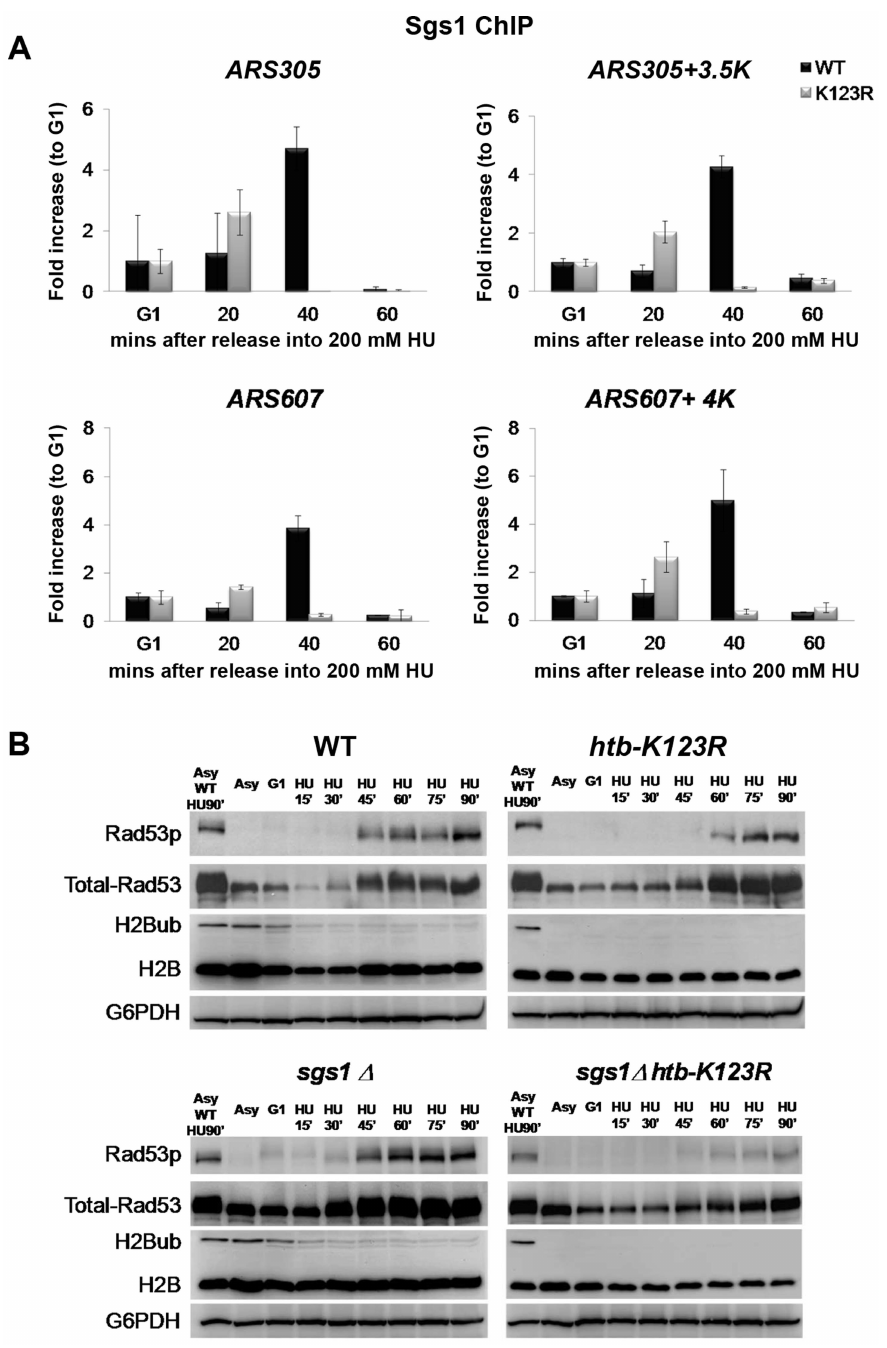
Figure 5. H2Bub and Sgs1 play interdependent roles in Rad53 phosphorylation. (A) Sgs1 occupancy at replication origins is unstable in htb-K123R cells exposed to HU. WT (CFK1764) or htb-K123R (CFK1765) cells were synchronized in G1 and then released into fresh YPD containing 0.2M HU for 60 minutes at 30 u C. Chromatin immunoprecipitation (ChIP) was performed using antibodies against Sgs1-3 6 Myc. DNA was quantified by qPCR using primers adjacent to ARS305 and a region 3.5 kb distal. Sgs1 occupancy at each time point was normalized to that of G1. (B) Activation of Rad53 is impaired in the absence of both H2Bub and Sgs1. WT (CFK1204), htb-K123R (CFK1231), sgs1 D (CFK1447), and sgs1 D htb-K123R (CFK1453) cells were arrested in G1 and released into fresh media containing 0.2M HU for 90 minutes at 30 u C. Whole cell lysates were prepared at the indicated time points, and analyzed by Western blot using antibodies against Rad53 (EL7), phospho-Rad53 (F9), H2B, and mono-ubiquitylated H2B (anti-FLAG). G6PDH was used as a loading